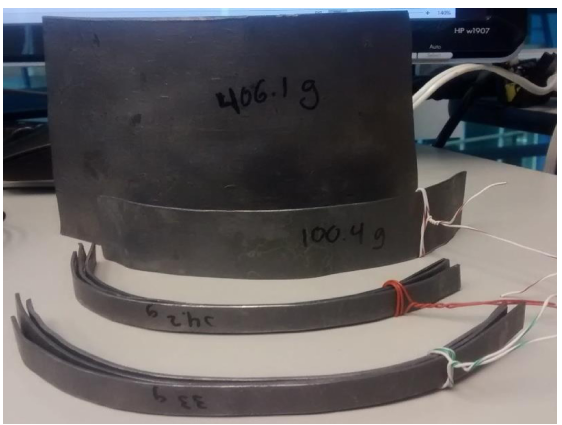
Figure 19. Weight